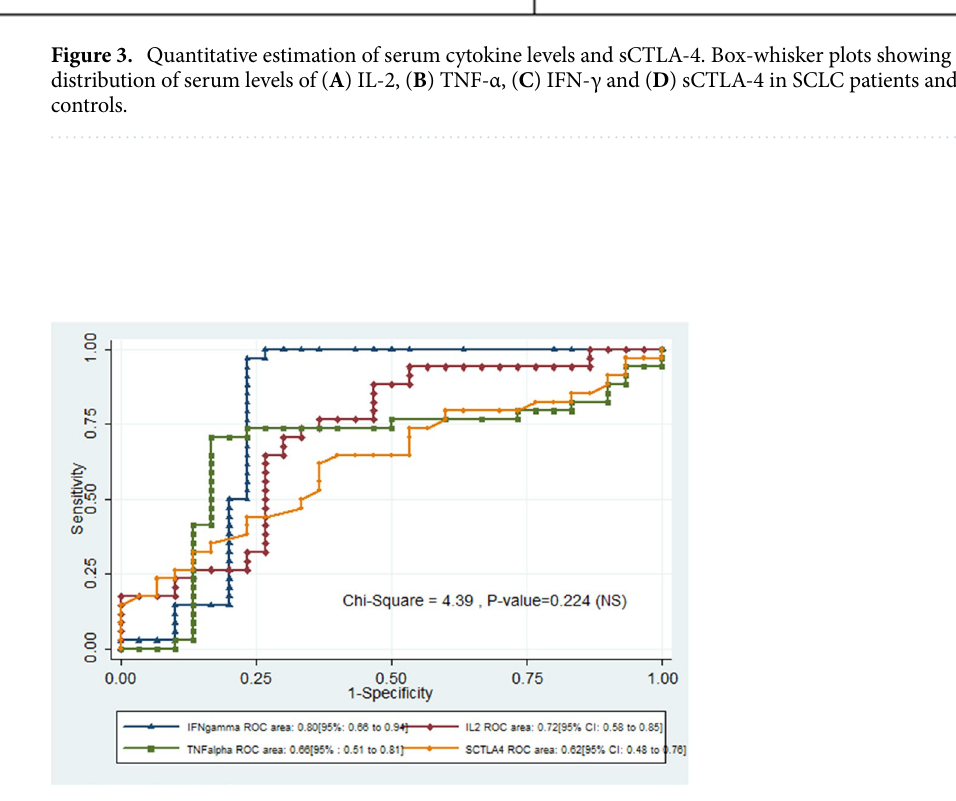
Figure 4. ROC curve comparing the discrimination potential amongst the serum